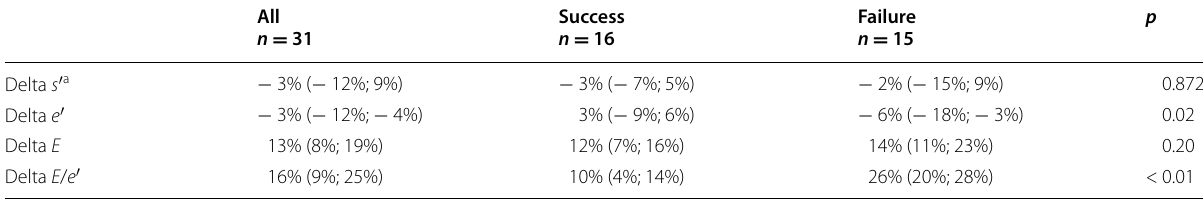
Data are presented as median (1st quartile; 3rd quartile) s ′ peak systolic velocity at the lateral mitral valve annulus, e ′ early peak diastolic velocity of mitral annulus, E early diastolic velocity measured using Doppler transmitral flow a s ′ could not be assessed in three